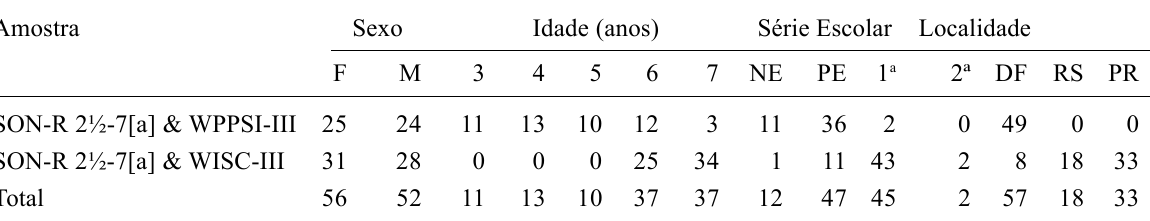
Nota . F = Feminino; M = Masculino; NE = Não Escolar; PE = Pré-Escolar; Faltou informação quanto a série escolar de duas crianças que responderam ao